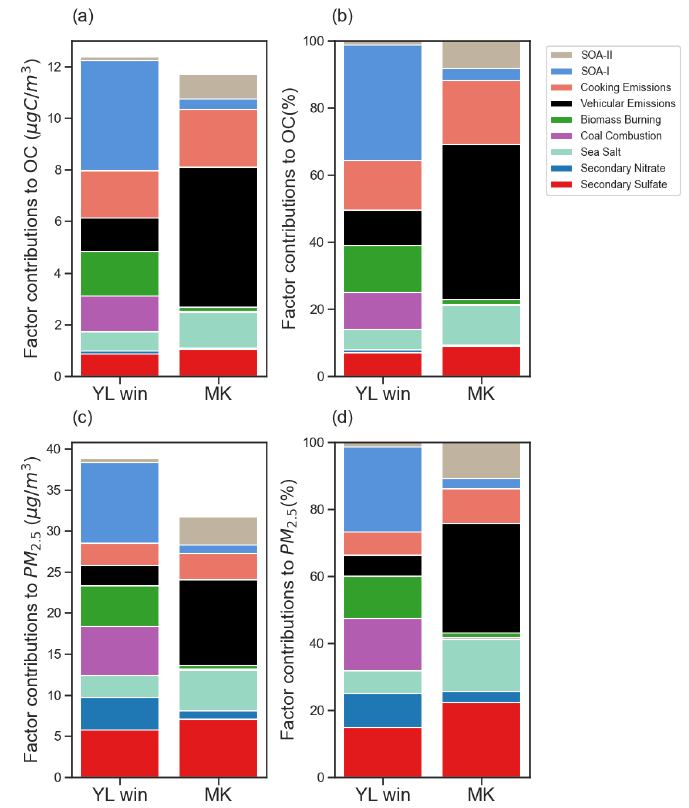
Figure 9. Modelled contributions from PMF CholC16C18 . ( a ) Modelled organic carbon (OC) contribution in mass concentration. ( b ) Modelled OC contribution (%). ( c ) Modelled PM 2.5 contribution in mass concentration. ( d ) Modelled PM 2.5 contribution (%).